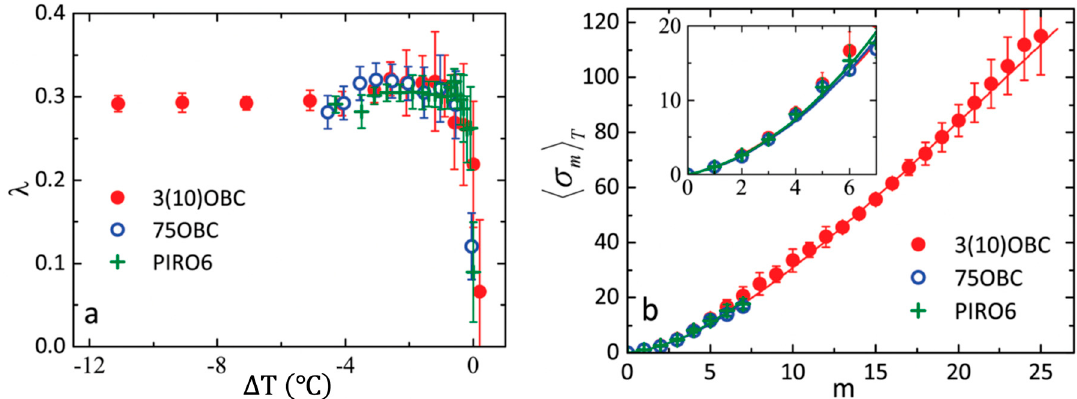
Figure 8. ( a ) Temperature dependence of the parameter λ for three LC compounds, obtained from the fits of experimental data with scaling relations of multicritical scaling theory (MCST). The relative temperature ∆ T = T − T c is measured from the Sm-A–Hex-B phase transition temperature T C ; ( b ) Temperature averaged values of (cid:104) σ m (cid:105) T and their fit with the MCST for three compounds. In the inset, an enlarged region for m values from one to seven is shown. (adopted from Zaluzhnyy et al. [17]–Published by The Royal Society of Chemistry) Used under CC-BY 3.0.